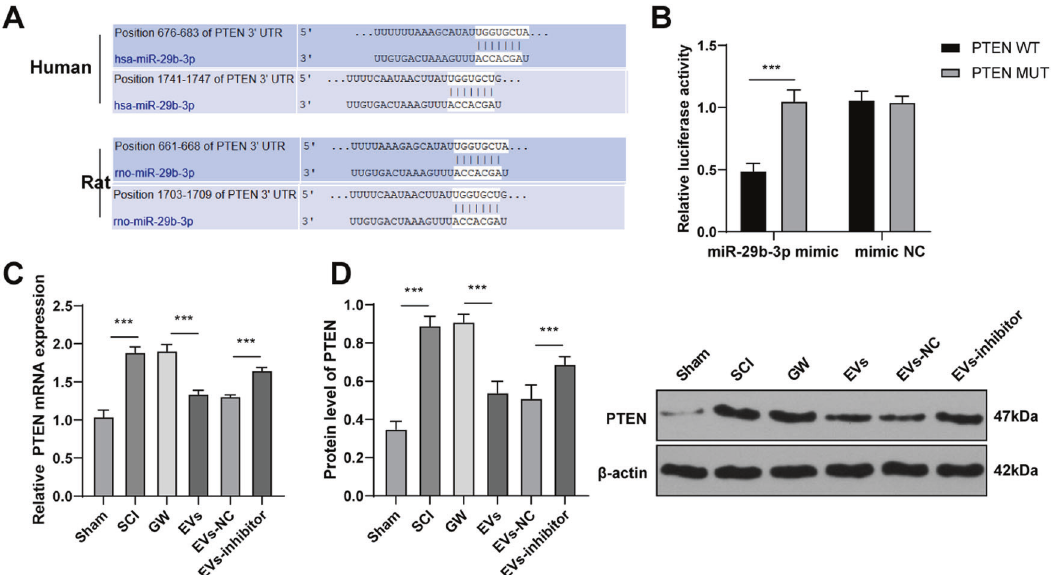
Fig. 5 miR-29b-3p targets PTEN. A The binding site between miR-29b-3p and PTEN in humans and rats was predicted by Targetscan. B The binding relationship between miR-29b-3p and PTEN was veri fi ed using a dual-luciferase reporter gene assay. C / D PTEN expression in spinal cord tissues of rats in each group was detected using RT-qPCR and Western blotting. N = 6. Data are expressed as mean ± standard deviation and analyzed using one-way ANOVA or two-way ANOVA, followed by Tukey ’ s multiple comparisons tests, *** p <